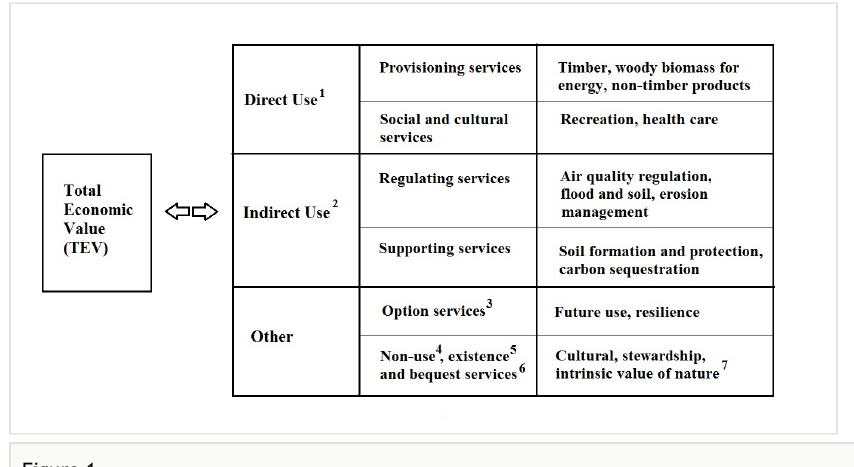
Key components of the Total Economic Value concept. Figure adapted from Glaves et al.